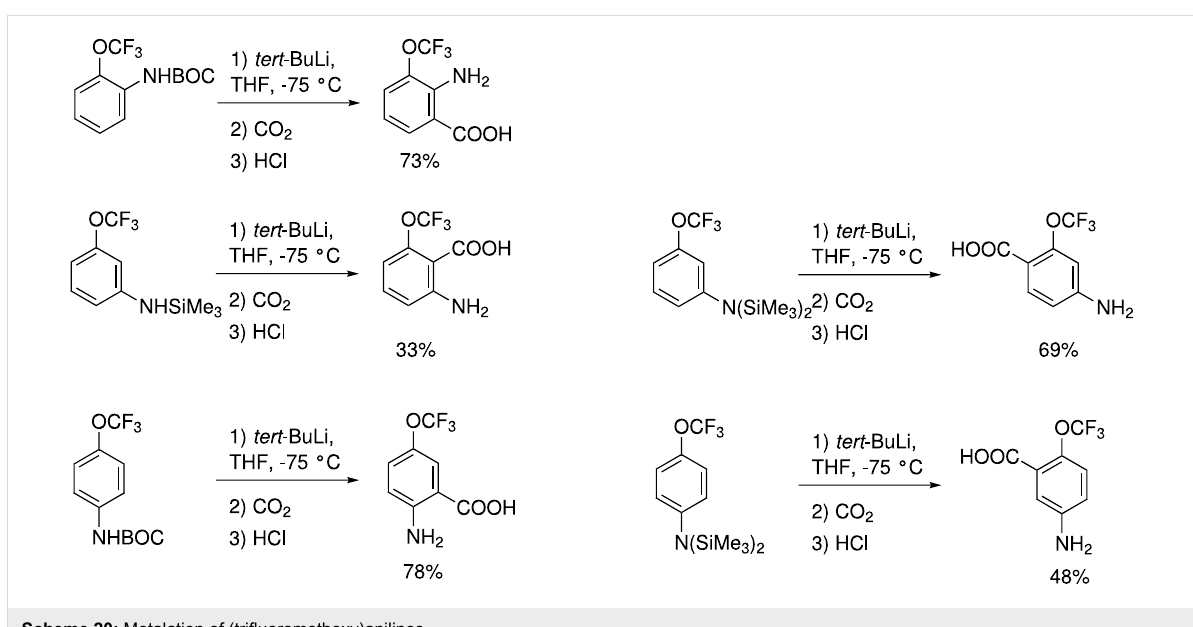
Scheme 20: Metalation of